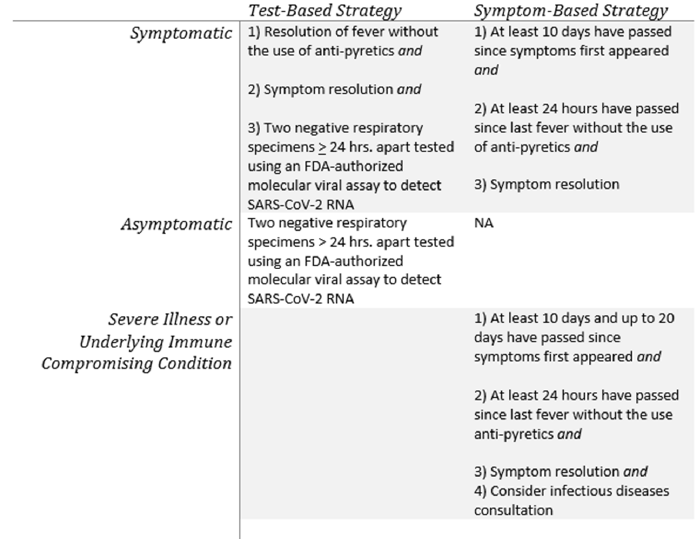
Figure 3. Summary of the Centers for Disease Control and Prevention (CDC) guidelines for the discontinuation of transmission-based precautions and disposition of patients with COVID-19 in healthcare settings. Recognizing that recovered COVID-19 patients may persistently shed inert non-infectious virus into clinical specimens, the CDC generally recommends a symptom-based rather than a test-based approach for symptomatic individuals [70]. (NA: Not applicable).